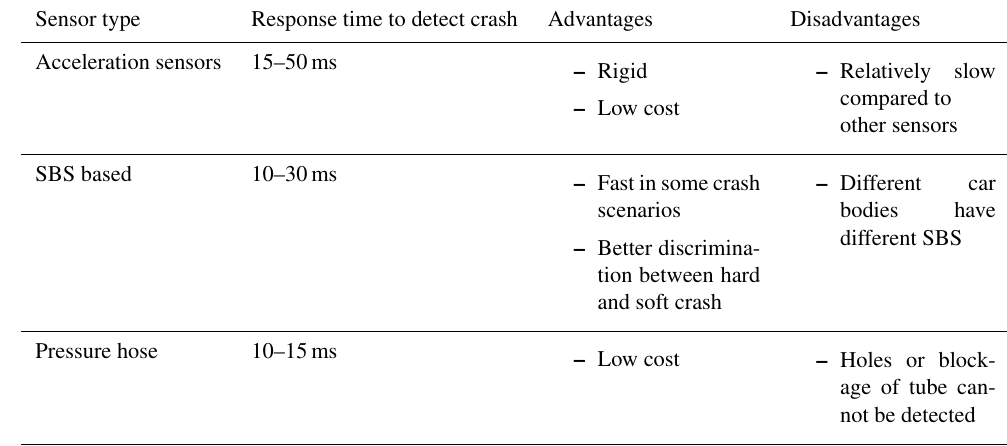
Table 1. Comparison of various sensors used for detecting frontal crash. ∗